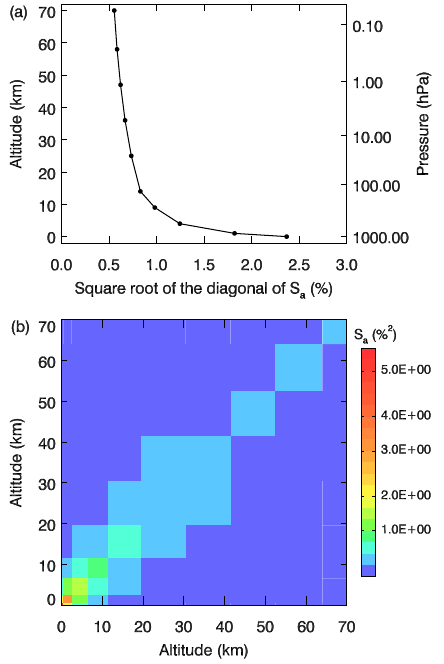
Fig. 4. (a) The square root of the diagonal in CO 2 covariance ma- trix. (b) The 2-D plot of the CO 2 covariance